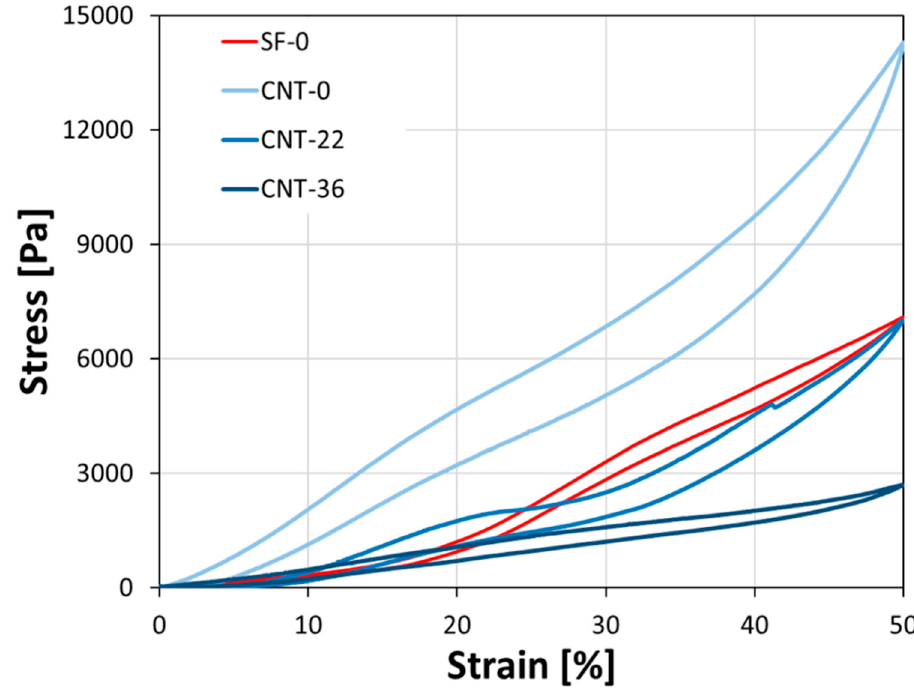
Figure 9. Stress–strain curves for composite foams during one cycle at an ε max of 50%.